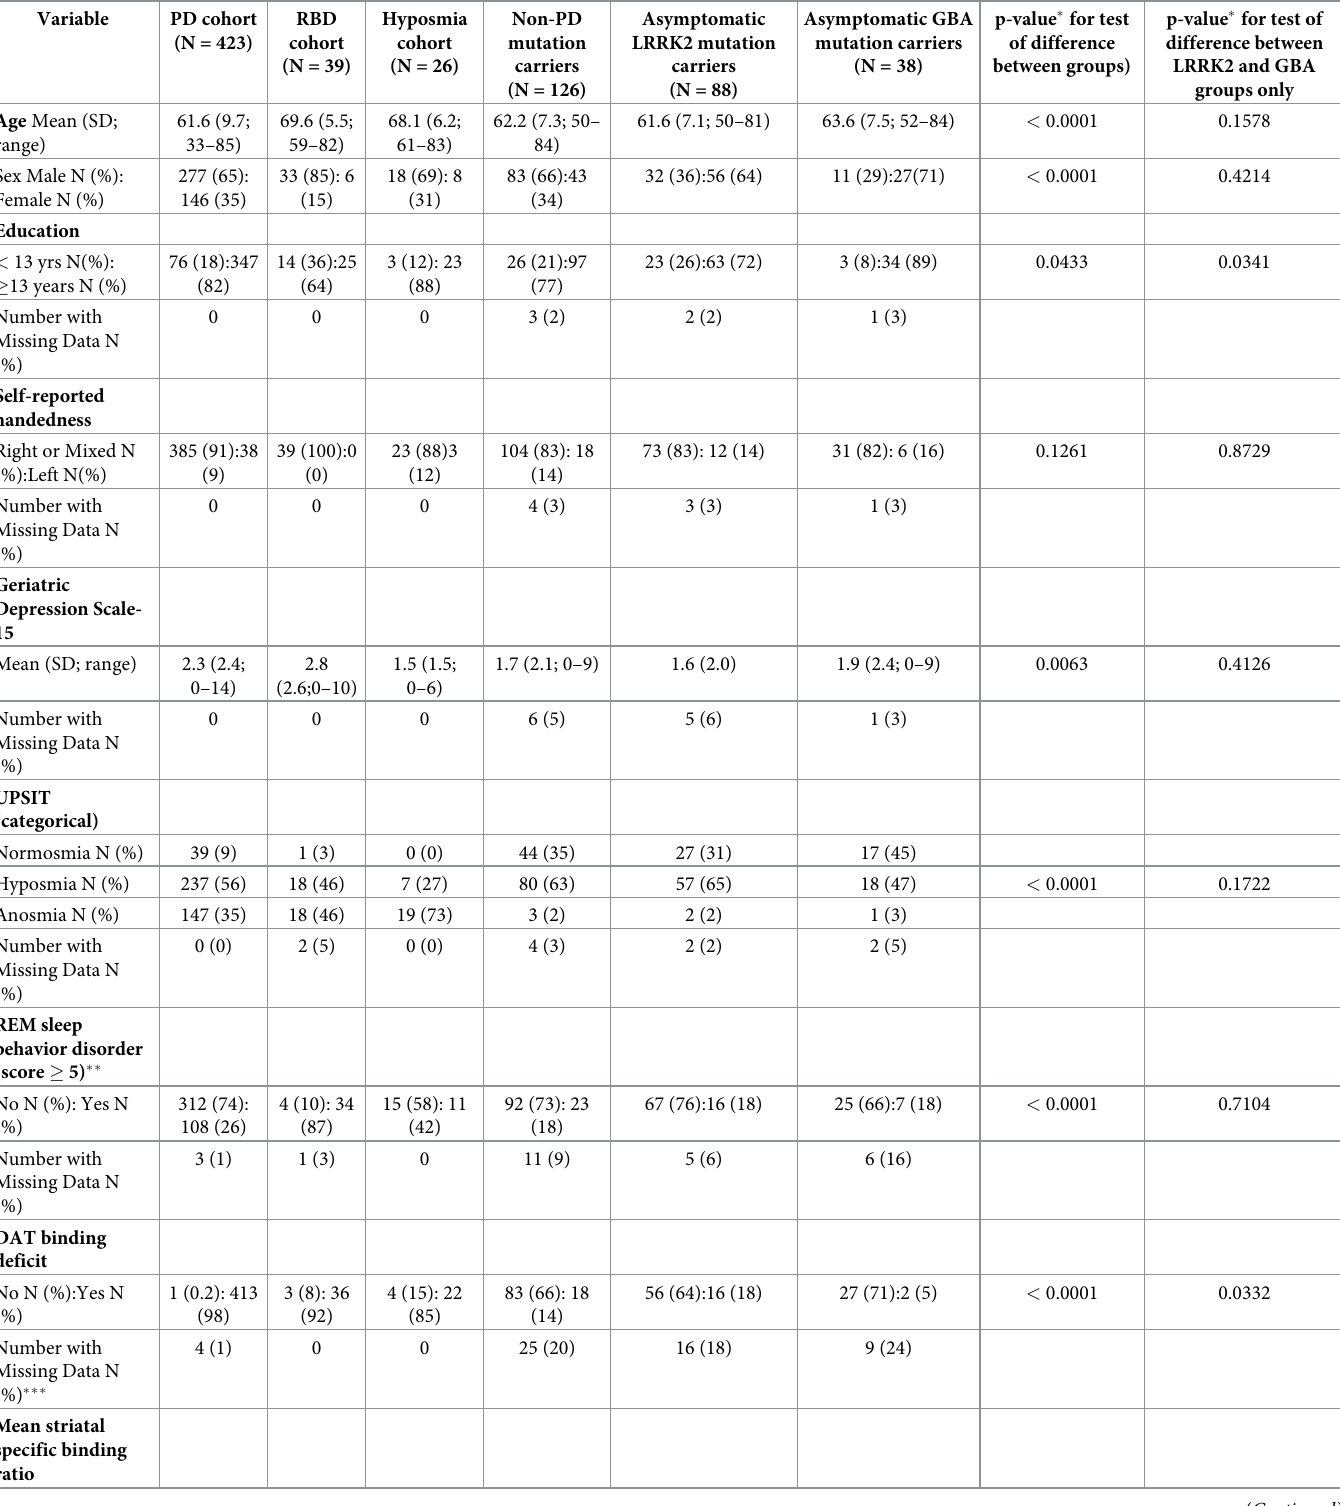
Table 1. Demographics, clinical, and DAT SPECT characteristics in the PD, RBD, Hyposmia, and non-PD mutation carrier groups.